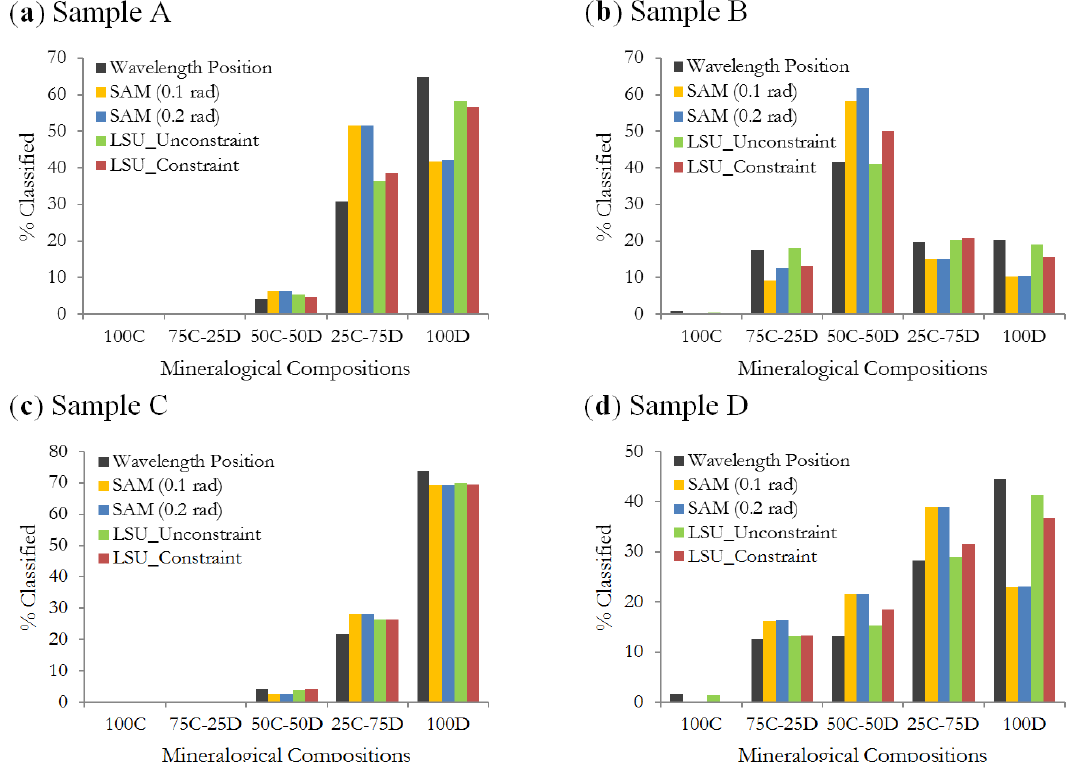
Figure 9. Histograms comparing proportion estimation of carbonate mineral mixtures of three spectral analysis techniques applied to the selected SisuCHEMA images. Samples slightly from one approach to another for a given